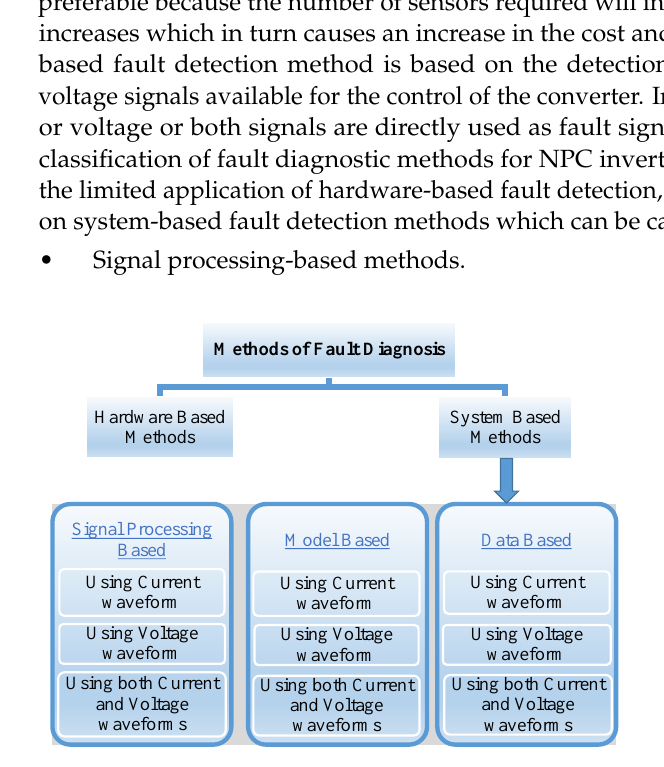
Figure 11. Classification of fault diagnostic